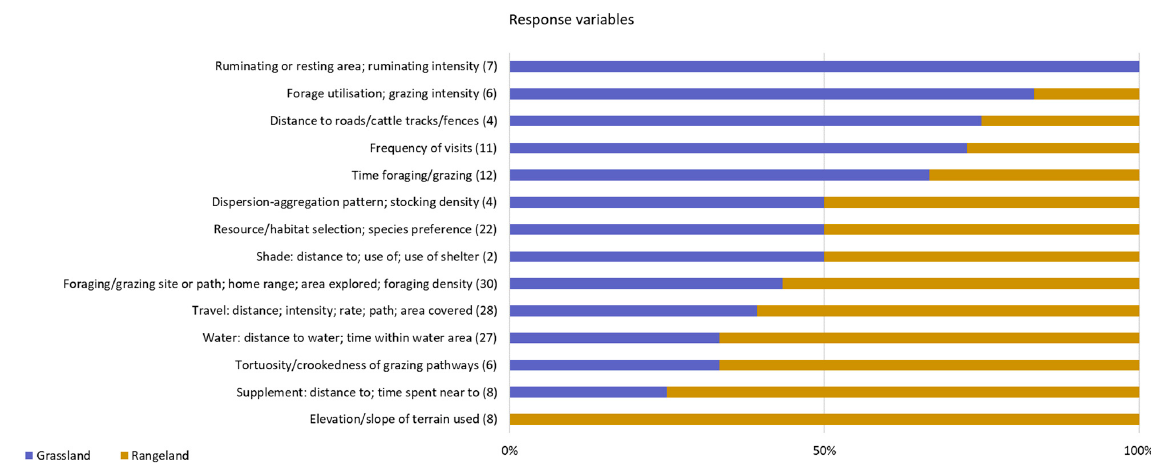
Figure 5. Response variables assessed in studies published between 2000 and 2020 on the use of GPS tracking on cattle to determine the factors affecting their site use preference on grazing systems (numbers between brackets refer to the total number of studies carried out nly in grasslands and rangelands that included each response variable class).